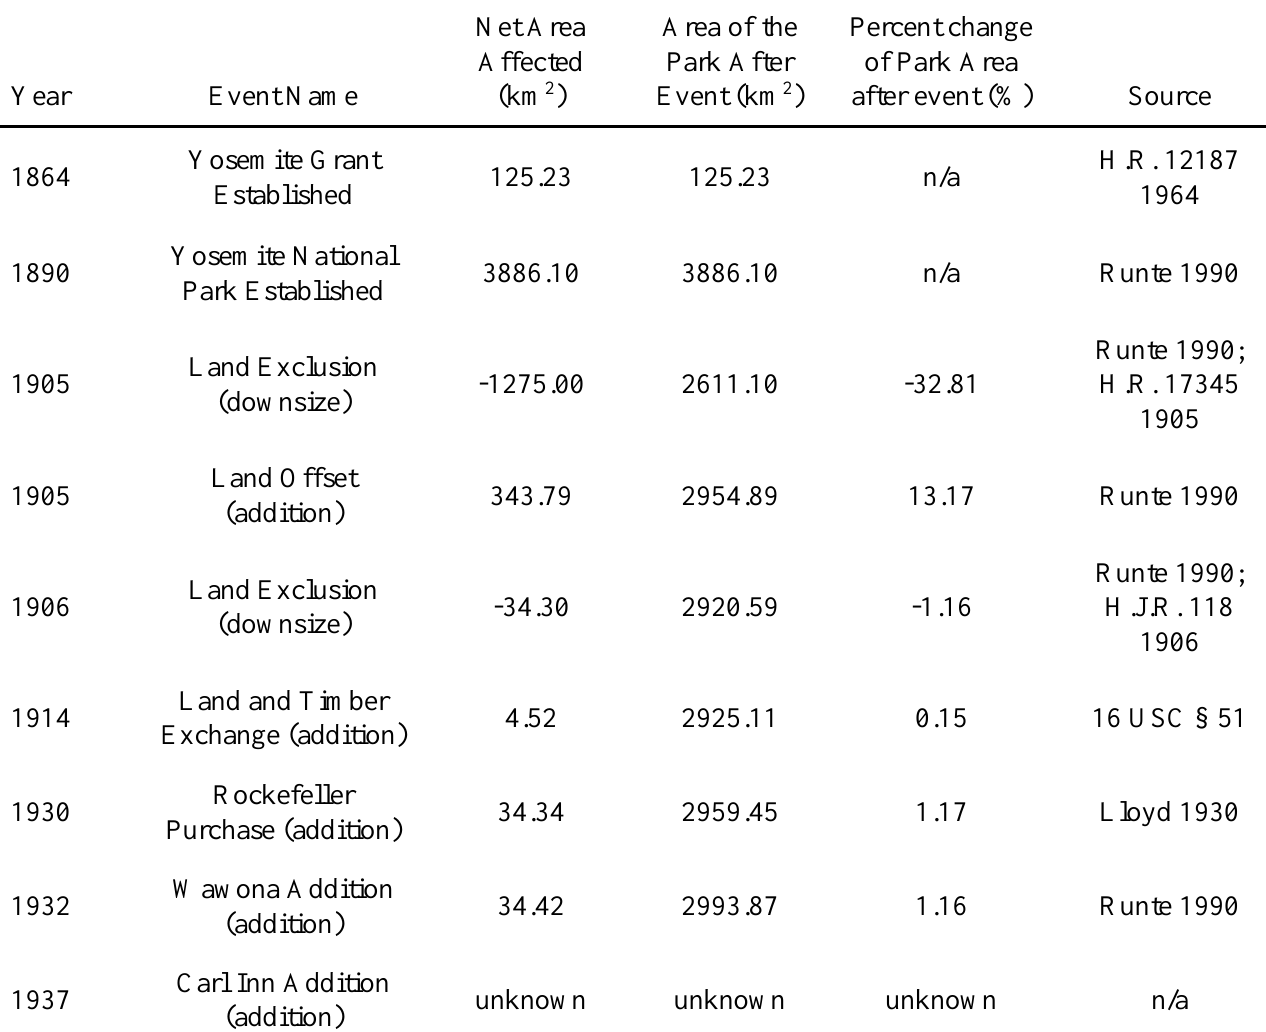
Table A1.4: Timeline of Yosemite Boundary Adjustments in Yosemite National Park. Area values calculated in ArcGIS